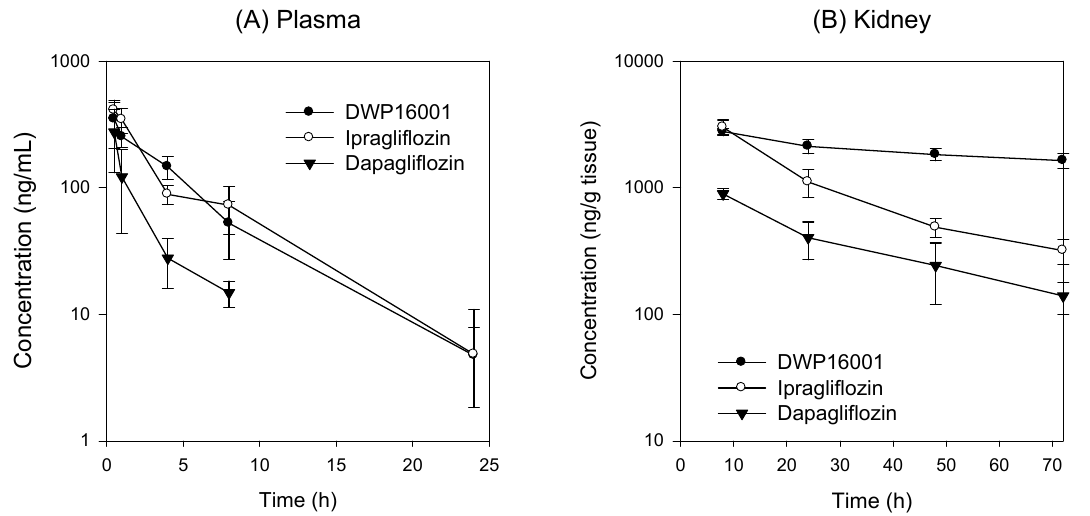
Figure 4. ( A ) Plasma and ( B ) kidney concentration vs. time profile of DWP16001 ( ● ), dapagliflozin ( ▼ ), and ipragliflozin ( ○ ) after a single oral administrations of DWP16001, dapagliflozin, and ipragliflozin at a dose of 1 mg/kg in Institute of Cancer Research (ICR) mice, respectively. Data are expressed as mean±SD from five mice. Table 1. Pharmacokinetic parameters of DWP16001, dapagliflozin, and ipragliflozin after a single oral administrations of DWP16001, dapagliflozin, and ipragliflozin at a dose of 1 mg/kg in ICR mice, respectively.